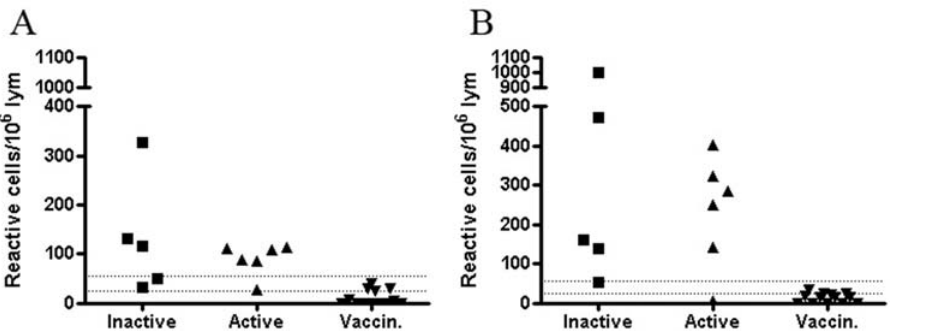
Figure 2. Production of IFN c by lymphocytes stimulated with ESAT-6 (Panel A) and CFP-10 (Panel B) was tested in the ELISPOT technique. The groups of patients with inactive TB (n=5), active TB (n=6) and healthy vaccinated subjects (n=13) were tested. Cell-mediated immunological responses were determined as the number of reactive cells per 10 6 lymphocytes. The lower dotted line is the level of positivity suggested by the manufacturer, the upper dotted line is the level of positivity adopted at the HUSLAB diagnostic laboratory. The area between the two dotted lines represents the so-called grey-zone, an area of uncertainty for interpretation that was calculated based on assay imprecision (data not published).